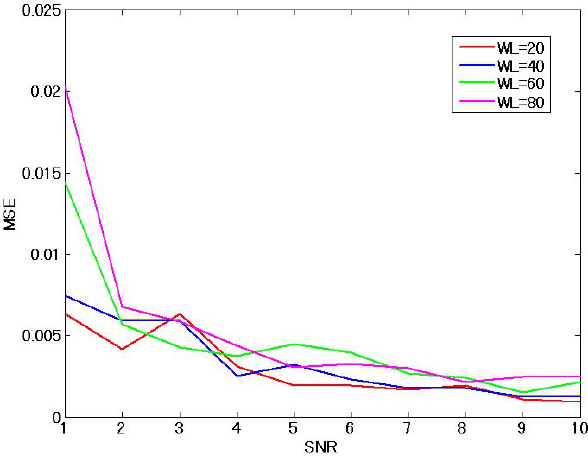
Fig. 10. The variation of MSE with the SNR for various